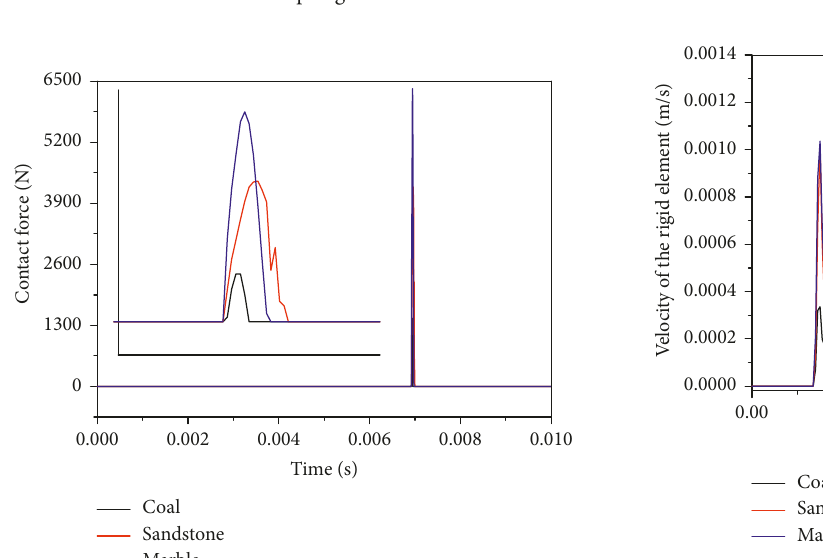
Figure 37: Spring stress. Figure 39: Acceleration of the tail beam.